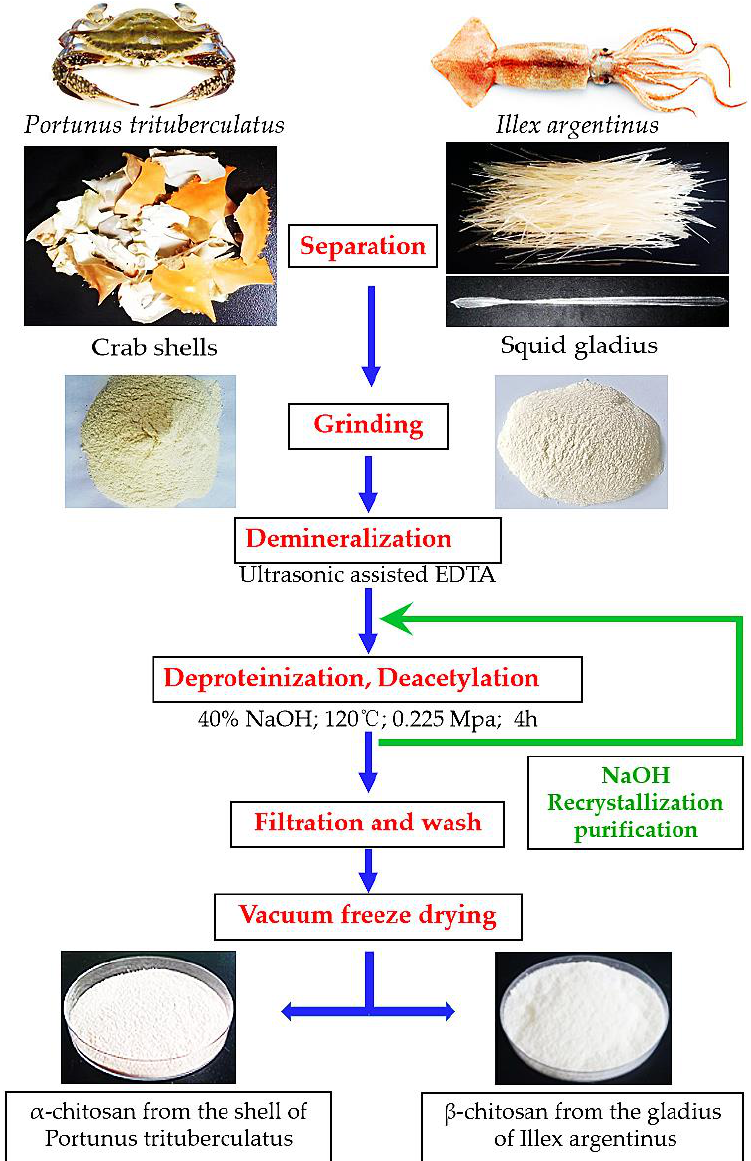
Figure 1. Flow scheme for the isolation of marine-derived chitosan.